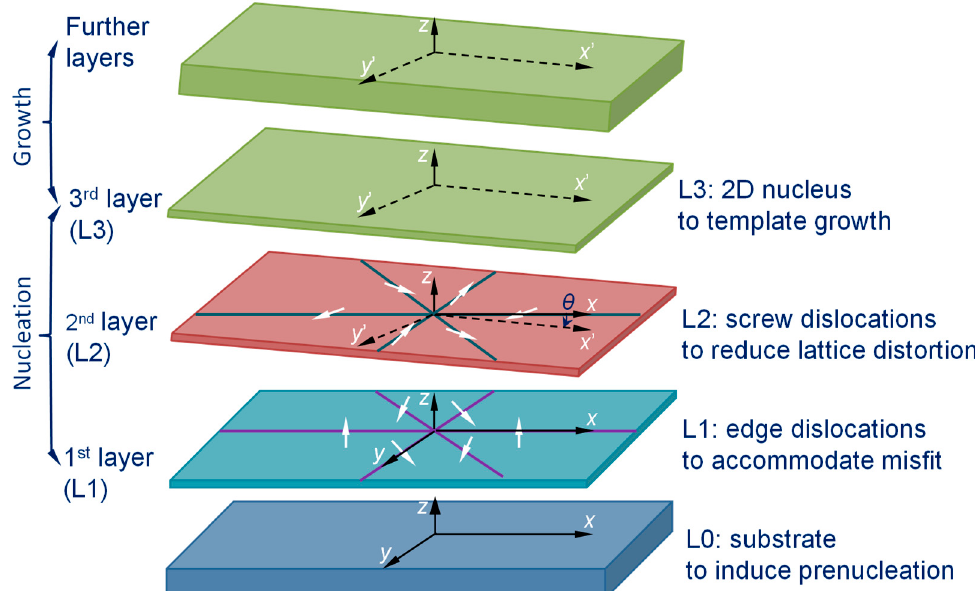
Figure 9. Schematic illustration of the three-layer nucleation mechanism for the system with negative lattice misfit. Building on the precursor (a 2D ordered structure) induced by the substrate at the prenucleation stage, at nucleation temperature, heterogeneous nucleation proceeds layer-by-layer through structural templating. L1 accommodates lattice misfit through an edge dislocation network; L2 twists an angle to reduce lattice distortion; and L3 is a plane of the solid (the 2-D nucleus) that templates further growth.